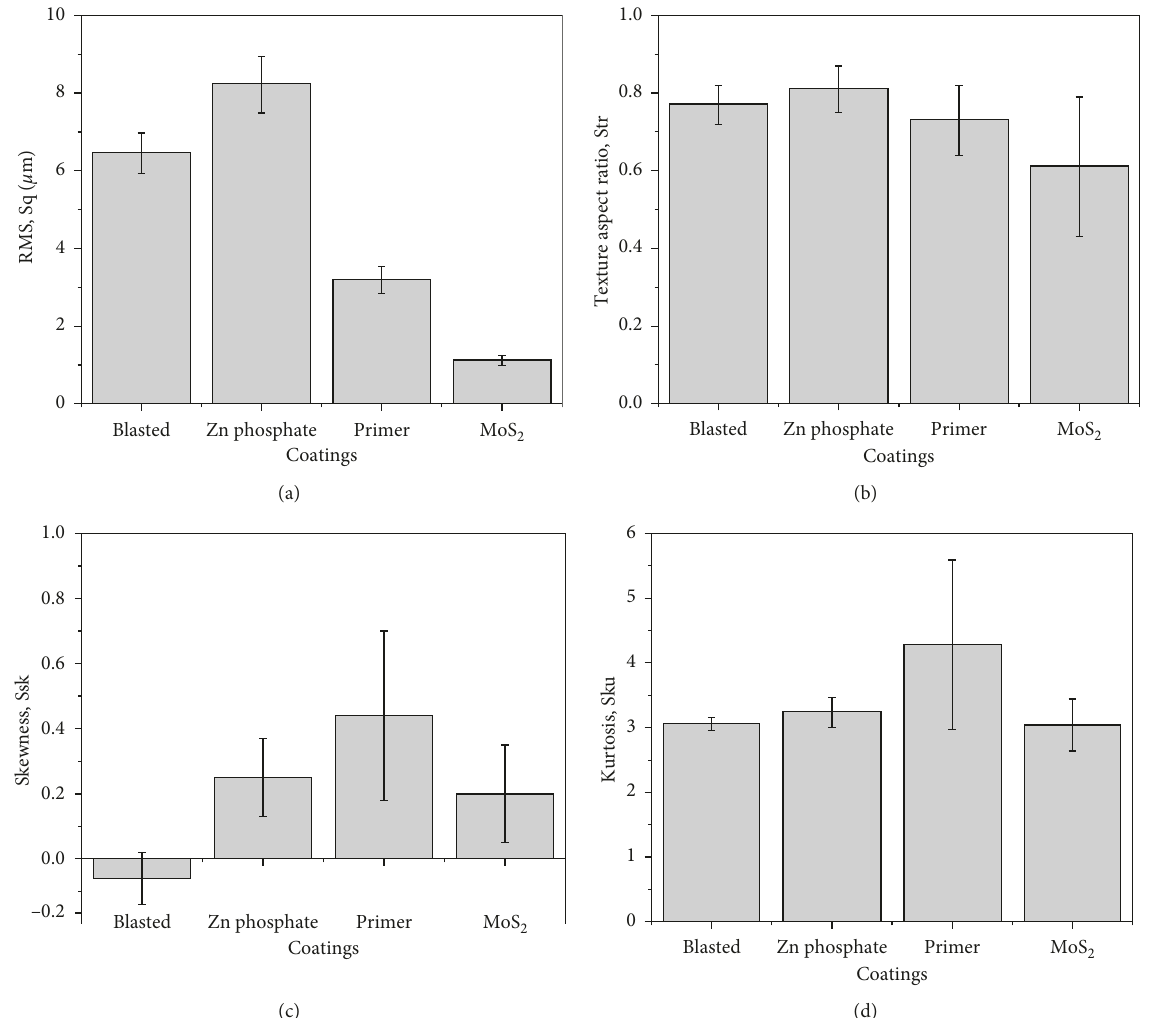
Figure 11: Average values of roughness parameters to each step of the layer’s deposition: (a) RMS Sq (mm); (b) texture aspect ratio Str; (c) skewness Ssk; and (d) kurtosis